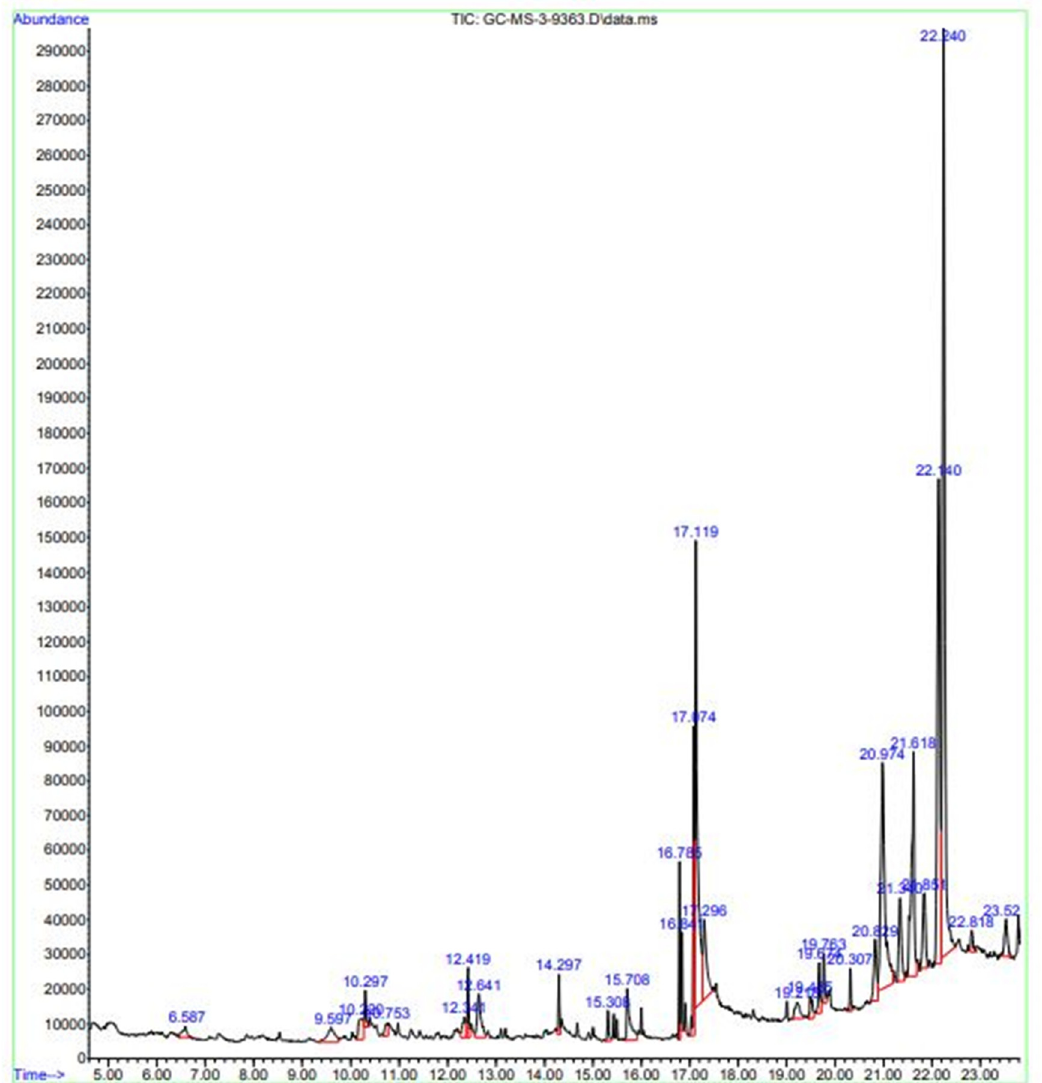
Figure 2: GC - MS spectrum of B. monnieri ethanolic